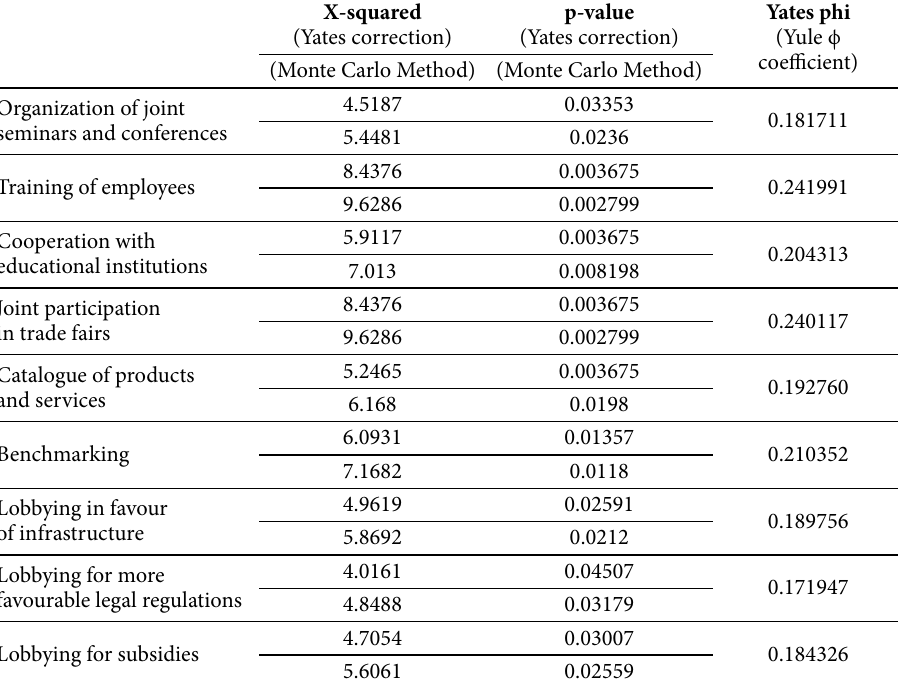
Table 3. Activities with a statistically-significant change in the structure of responses according to the age of